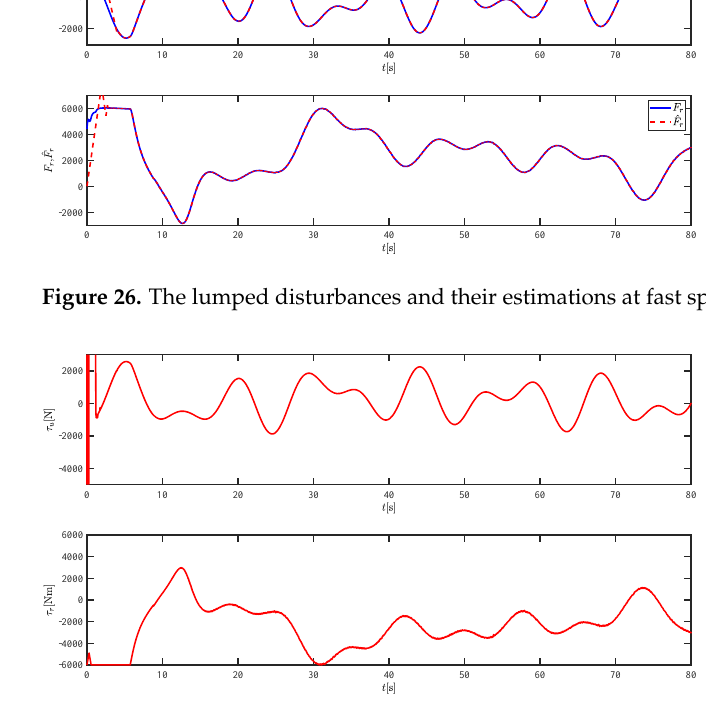
Figure 27. The force τ u and moment τ r at fast speed.